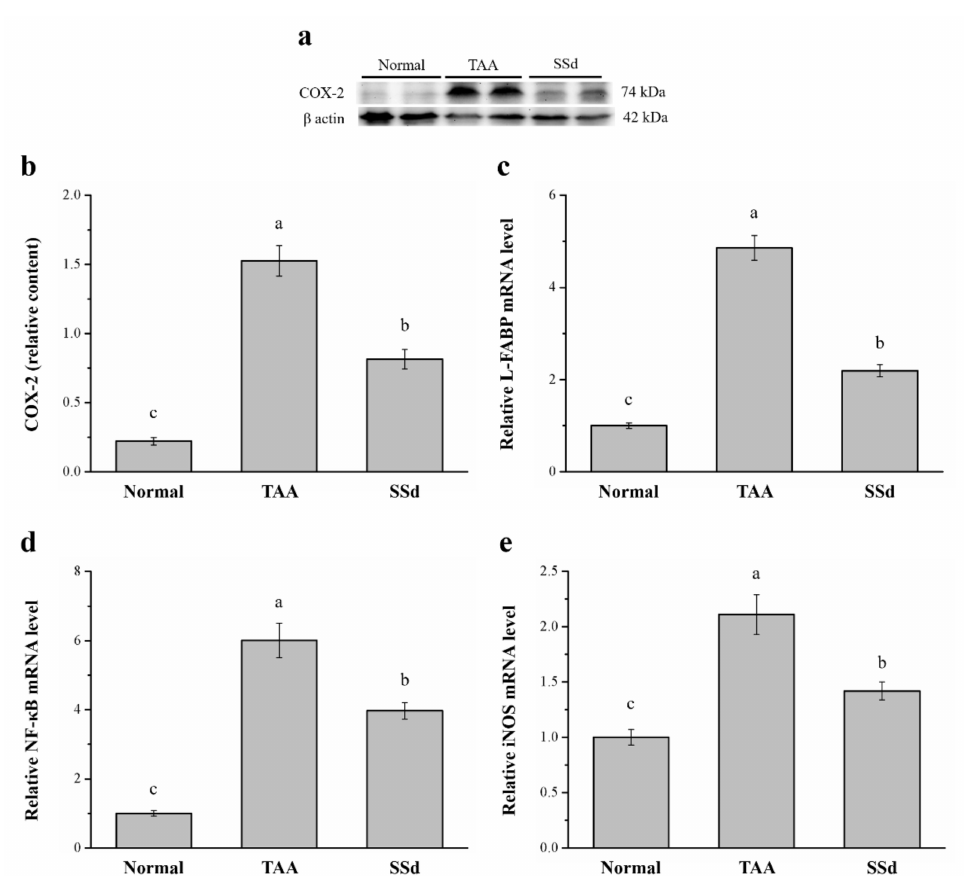
Figure 5. ( a ) Representative Western blot of liver extracts for COX-2 expression in the control, TAA, and SSd groups. ( b ) COX-2 expression and changes in ( c ) L-FABP ( d ) NF- κ B , and ( e ) iNOS mRNA levels in hepatocytes in the control, TAA, and SSd groups over 8 weeks. All data are reported as means ± SEMs (n = 8). a–c Data with different letters above the columns were significantly different on one-way ANOVA, and Duncan’s test at p < 0.05 was used to compare the means of the three groups. COX-2, cyclooxygenase-2; L-FABP, liver fatty acid–binding protein; NF- κ B, nuclear factor kappa B; iNOS, inducible nitric oxide synthase; mRNA, messenger RNA; SEM, standard error of the